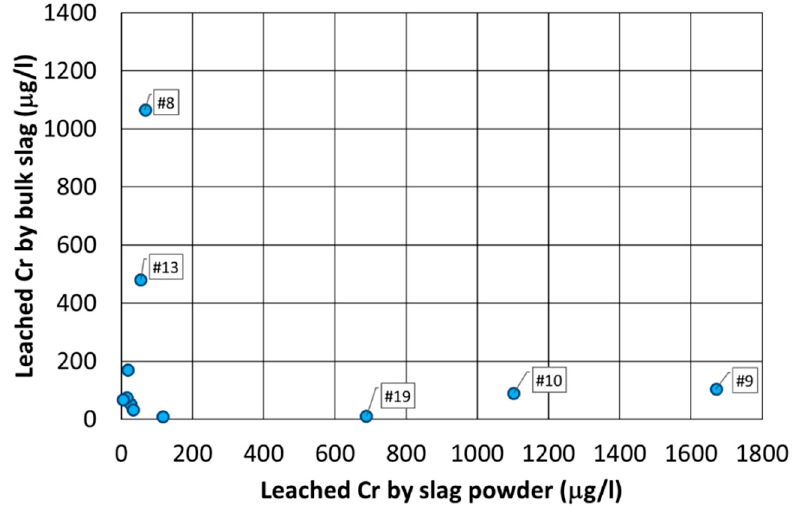
Figure 1. Relation between Cr leached by bulk slag (standard conditions) and by slag powder (marked samples represent remarkable behavior slag).